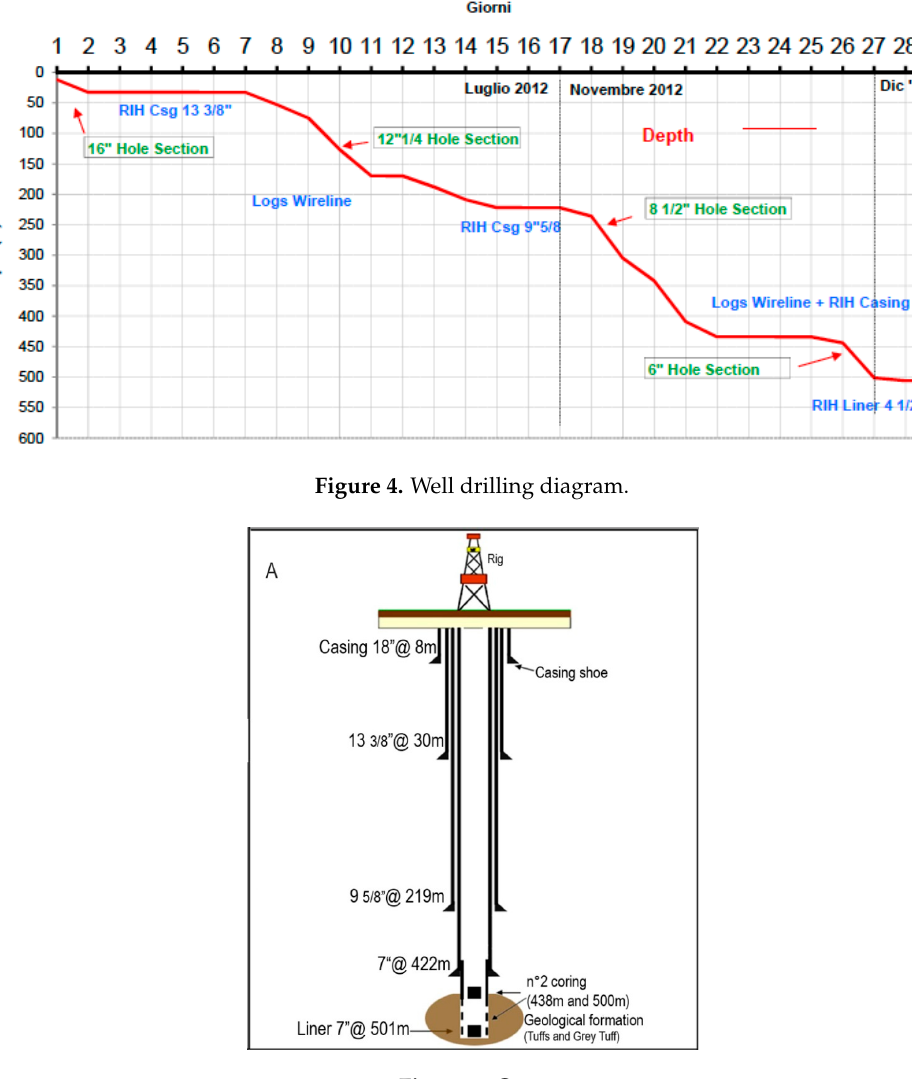
Figure 5. Cont. Figure 5.